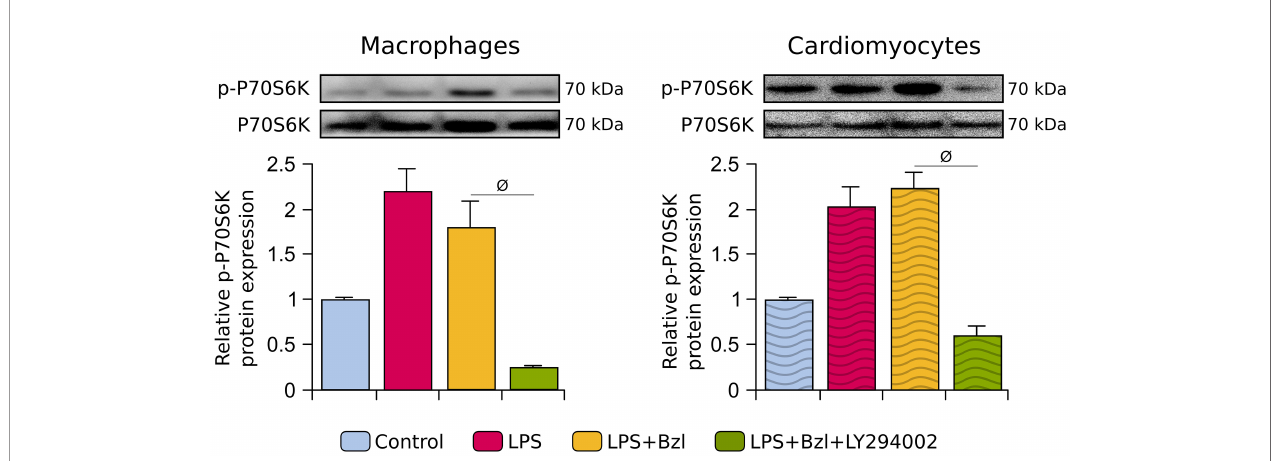
FIGURE 2 | RAW 264.7 macrophages and neonatal primary cardiomyocytes were treated with 30 m M LY294002, a non-isoform-selective inhibitor of PI3K, 30 min before the addition of 15 m M benznidazole (Bzl). Cells were stimulated with 10 µg/mL of LPS 30 min after Bzl treatment. After 30 minutes, relative p-P70S6K (70kDa) protein expression was determined by Western blot with a speci fi c antibody and normalized against total P70S6K (70kDa). Results are expressed as the mean of 3 independent experiments (n=3, 5 replicates/treatment) ± SEM. f P < 0.05 vs . Bzl-treated and LPS-stimulated